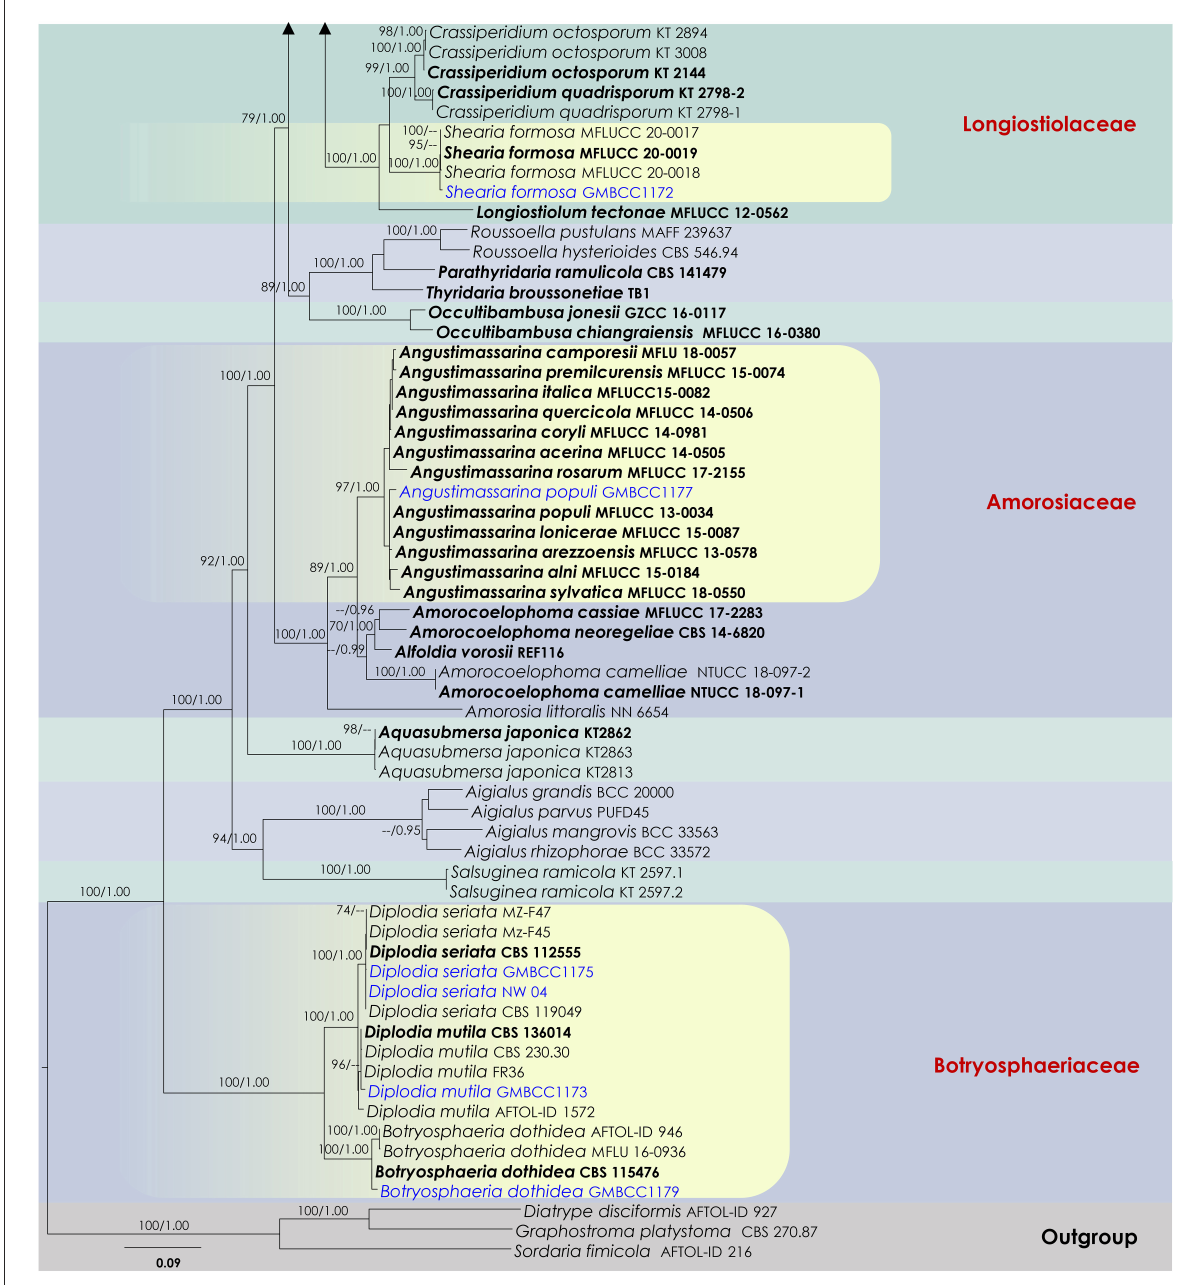
FIGURE1 RAxML tree based on a combined dataset of partial SSU, LSU, ITS, tef1 , and rpb2 DNA sequence analyses. Bootstrap support values for ML equal to or > 70%, Bayesian posterior probabilities (BYPP) equal to or > 0.95, are shown as ML/BI above the nodes. The type of strains is in bold, and new isolates are in blue. The scale bar represents the expected number of nucleotide substitutions per